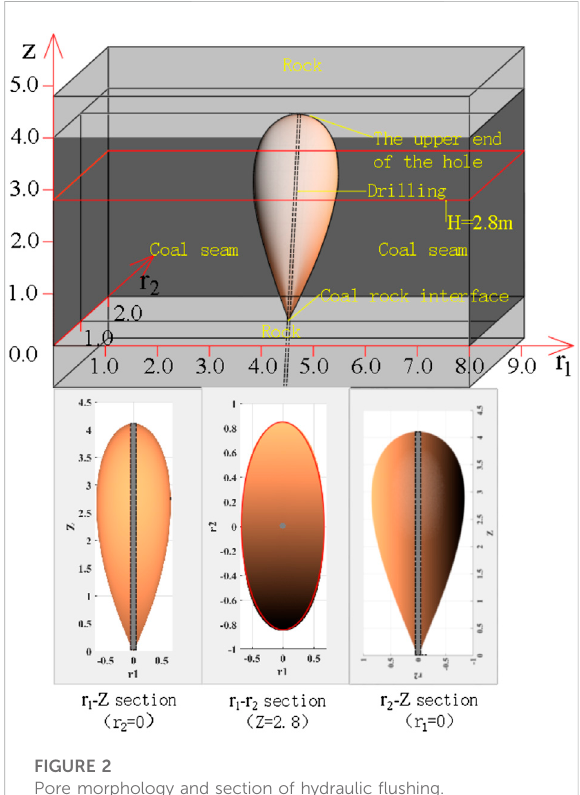
FIGURE 2 Pore morphology and section of hydraulic fl